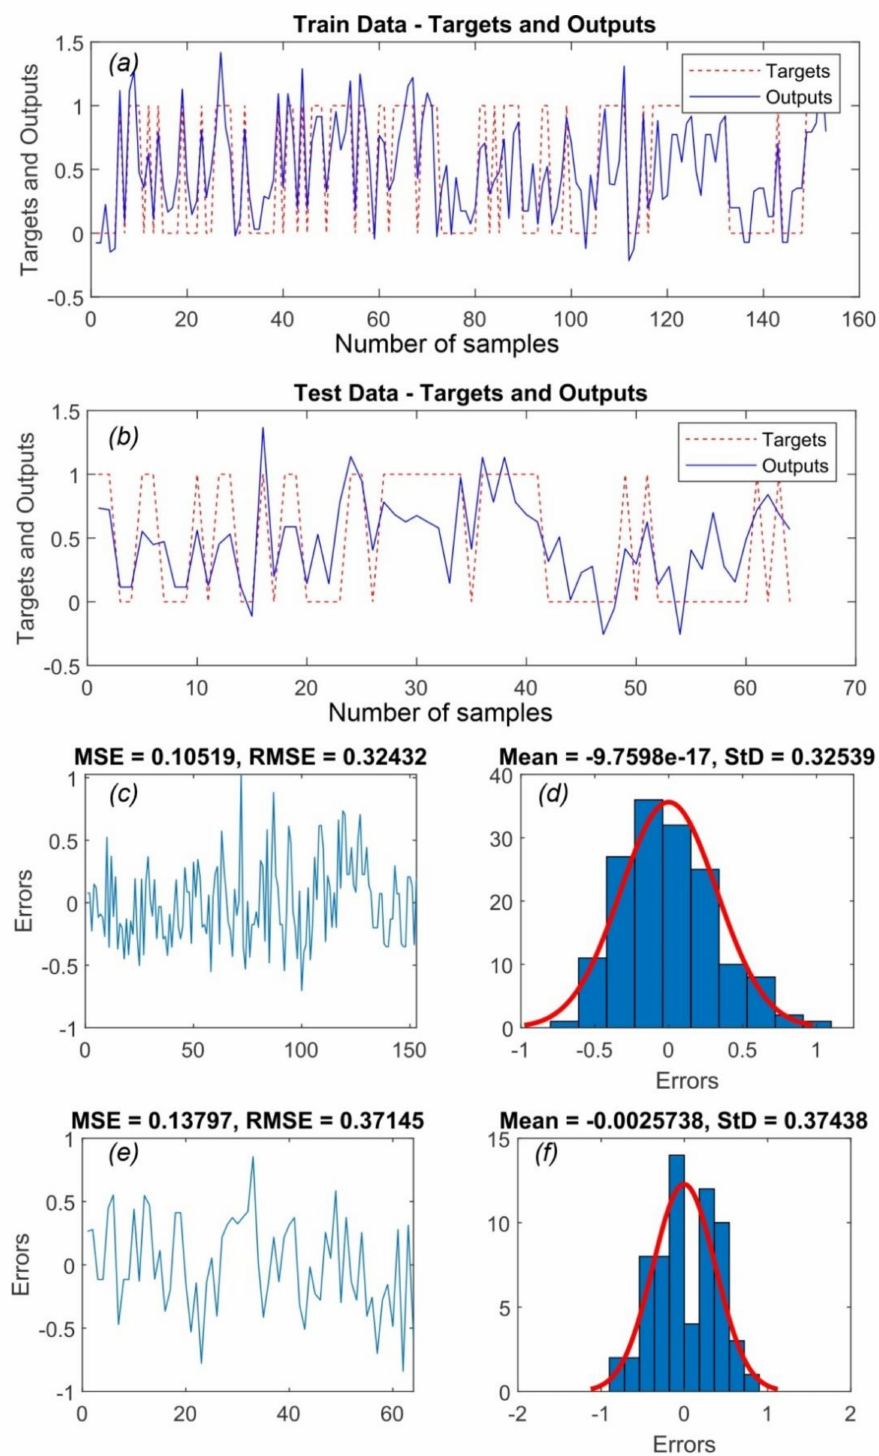
Figure 6. ( a ) Target value and output of ANFIS-SA model for training data, ( b ) target value and output of ANFIS-SA model for test data, ( c ) MSE and RMSE values of training samples, ( d ) frequency errors of training samples, ( e ) MSE and RMSE value of test samples, and ( f ) frequency errors of test